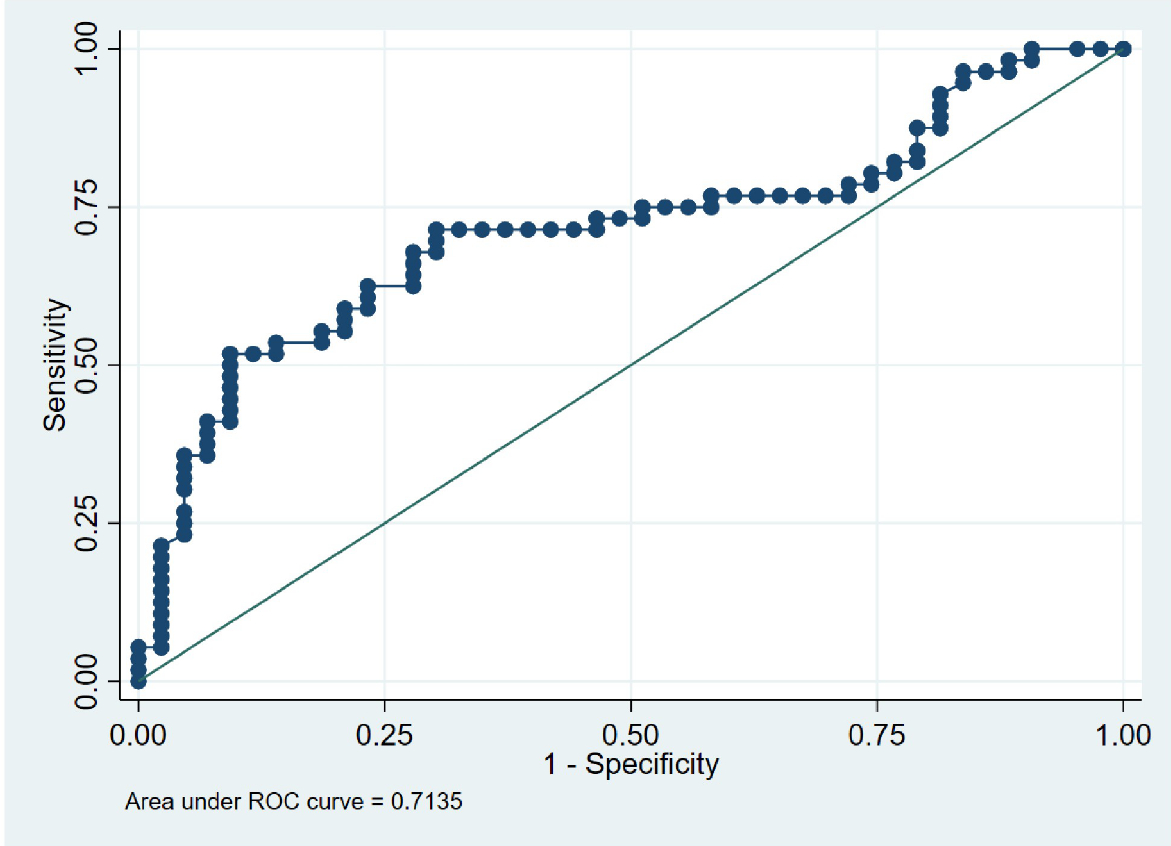
Fig 5. ROC curve showing an accuracy of LL-37 in differentiating between active TB and those without TB infection with a sensitivity of 71.4% and specificity of 69.8%.